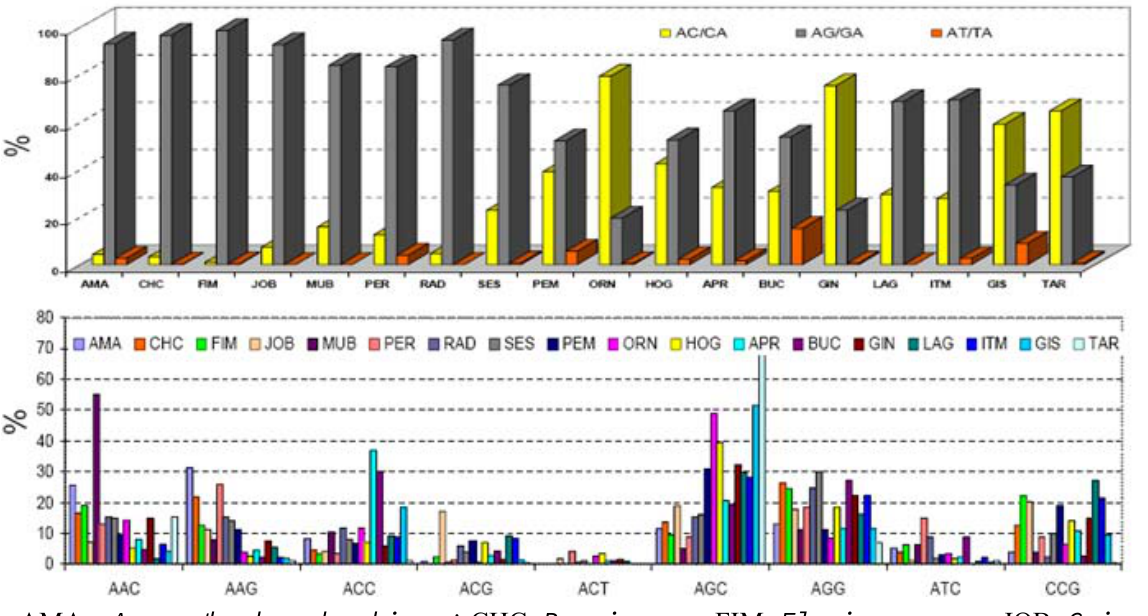
Figure 3. Frequencies of different classes of di-and tri-nucleotide repeat motifs in 18 underutilized crop